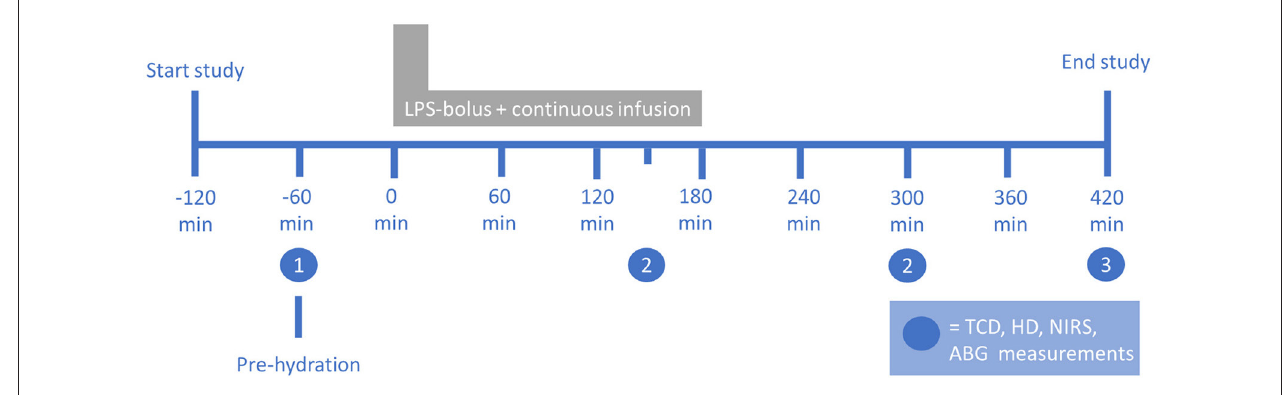
FIGURE 1 | Setup of the human endotoxemia trial. The numbers indicate the measurements at (1) baseline, (2) systemic inflammation, and (3) the end of the experiment. ABG, arterial blood gas; HD, hemodynamic; LPS, lipopolysaccharide; NIRS, near-infrared spectroscopy; TCD, transcranial Doppler. Figure reproduced with permission from Figure 1 in Van den Brule et al., Shock (2018), doi: